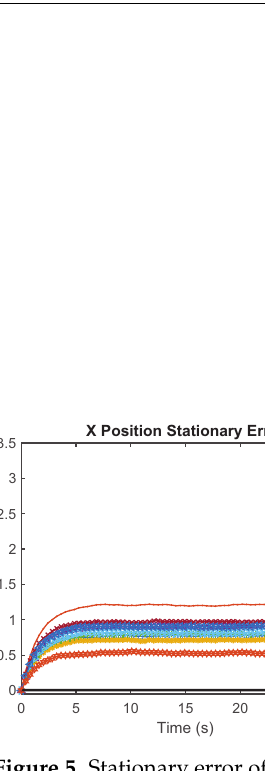
Figure 5. Stationary error of the individual IMUs fused with the Kalman filter without the magnetometer plotted alongside reference. The three positions indicate the IMU sensor axis aligned with gravity.